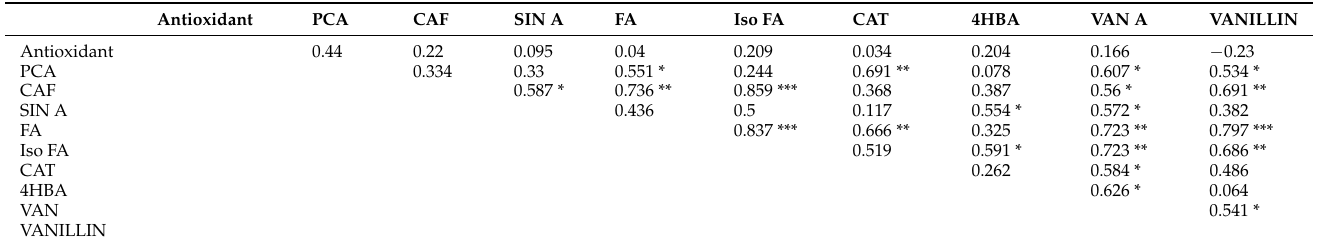
Figure 6. Antioxidant activity in tested barley grain samples. Data are expressed as Trolox equivalents (TE) per gram of the starting sample (i.e., µ M TE/g). Error bars represent the standard deviation of three replicates each. Values sharing the same letter are not significantly different at the level ≤ 0.05 using Tukey test. Table 5. Correlation matrix depicting the relationship between the antioxidant activity (ABTS) assay and individual bound phenolic compounds in barley